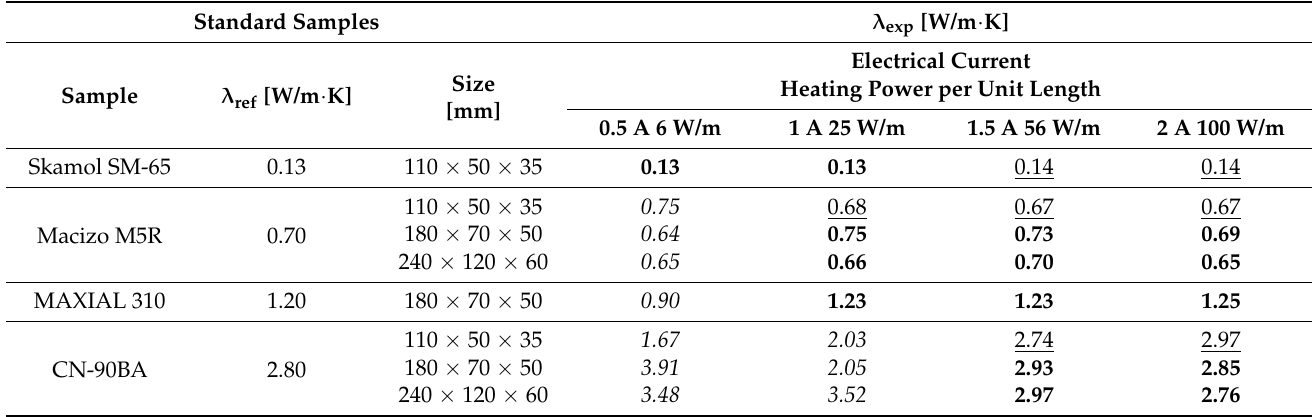
Table 4. Thermal conductivity obtained with the TCMA in the standard samples.